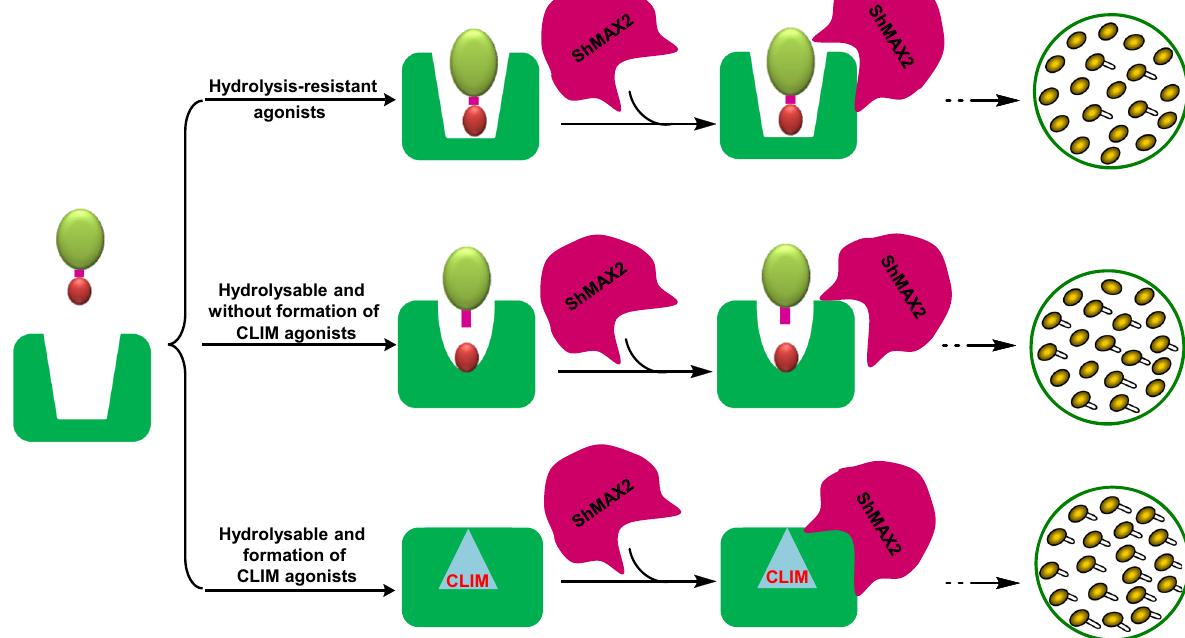
Fig. 6 A proposed structure – perception relationship model of synthetic SL agonists by ShHTL7 in the signal transduction pathway. For hydrolysis- resistant agonists (i.e., compound 4i ), ShHTL7 might bind with the intact molecule in the open conformation and trigger downstream signaling; however, the ef fi ciency is rather low. For hydrolyzable agonists, compounds that are less prone to result in CLIM modi fi cation of ShHTL7 showed lower potency in activating the signal transduction than compounds that are more prone to result in CLIM modi fi